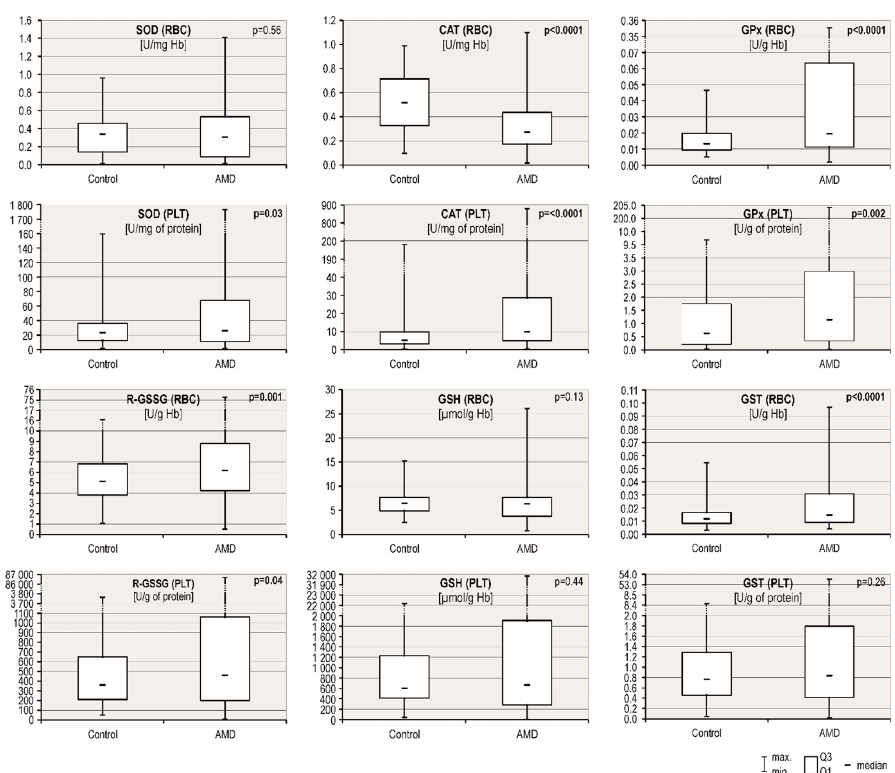
Figure 1. Comparison of the antioxidant system component levels in patients with AMD and controls. p -values < 0.05, which were considered statistically significant, are shown in bold.